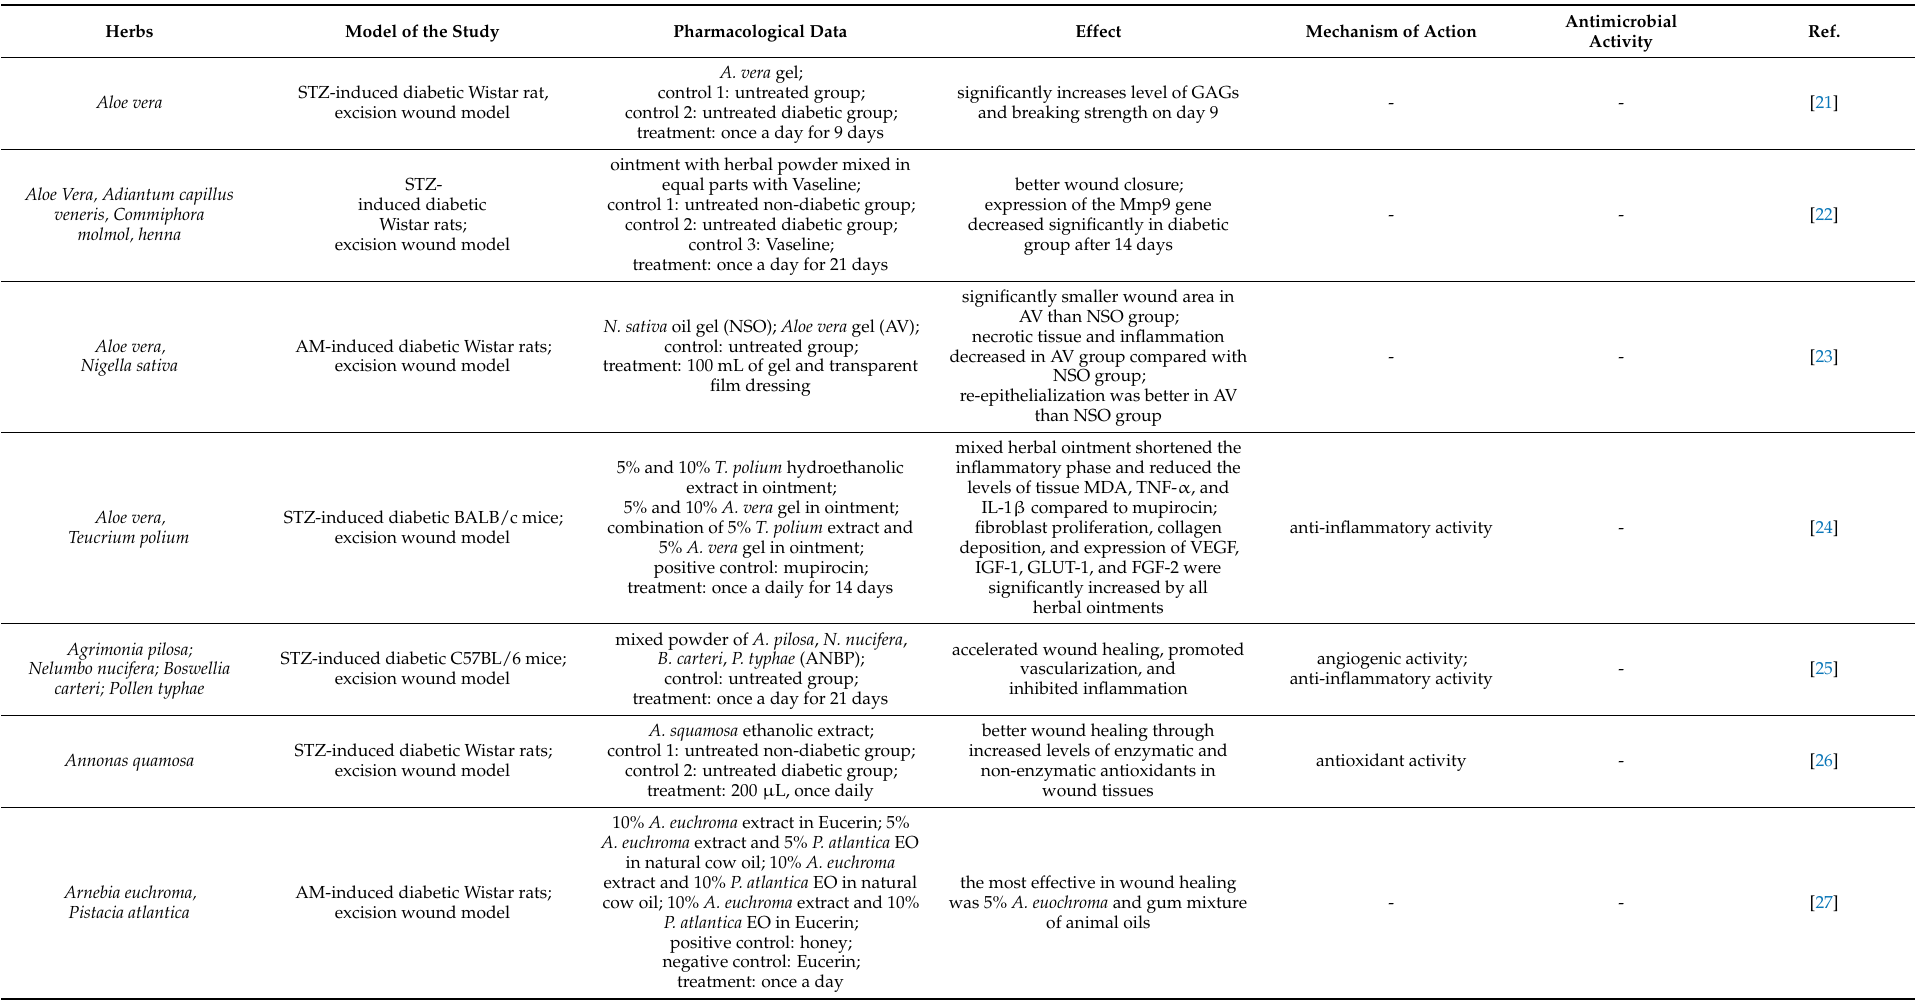
Table 1. Herbal products used for diabetic wound healing, animal-based